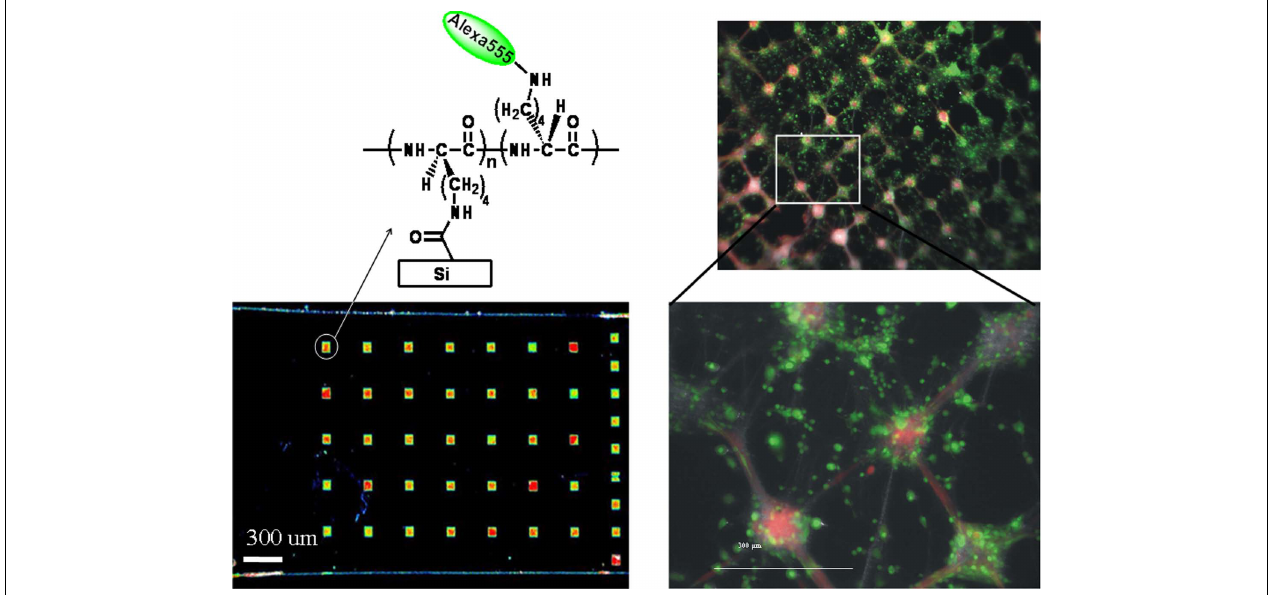
FIGURE 13 | Proof-of-concept demonstration of chemical patterning of fluorescently labeled polylysine (left) using conventional photolithography, followed by culture of cryopreserved rat cortical neurons (right). Cells were visualized by staining with Calcein (viability) and RH-237 (membrane) dyes. Adapted from Diaz-Quijada et al.